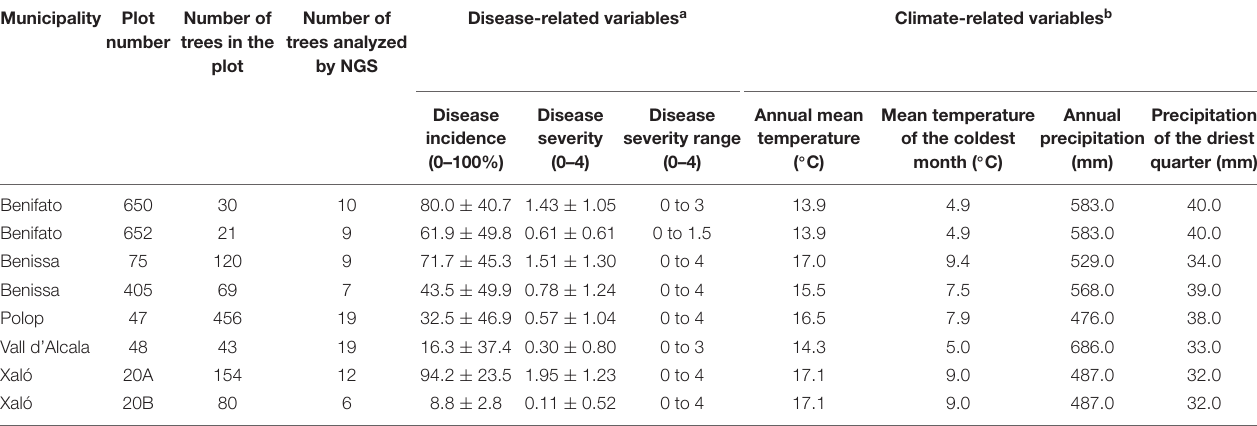
TABLE 1 | Disease incidence and severity of almond leaf scorch disease (ALSD), and climatic characteristics of almond orchards sampled in this study within the demarcated area (DA) for Xylella fastidiosa in Alicante province. Municipality Plot Number of Number of Disease-related variables number trees in the trees analyzed plot by NGS